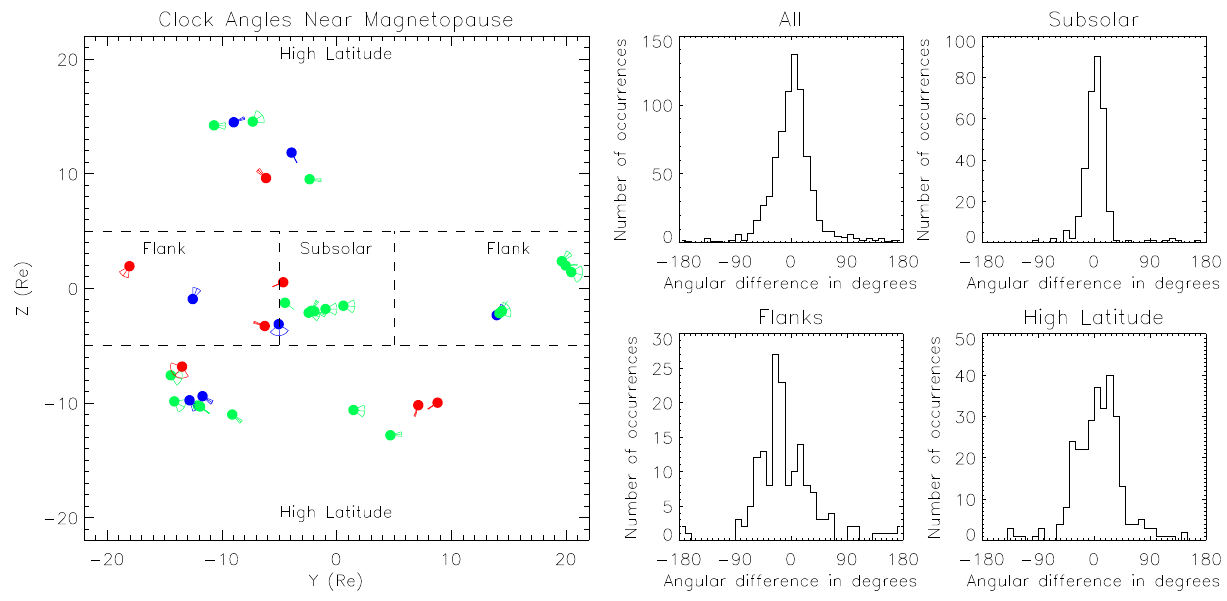
Fig. 6. Clock angles measured near magnetopause, and angular differences from perfect draping, for IMF with B y positive. Format as Fig.